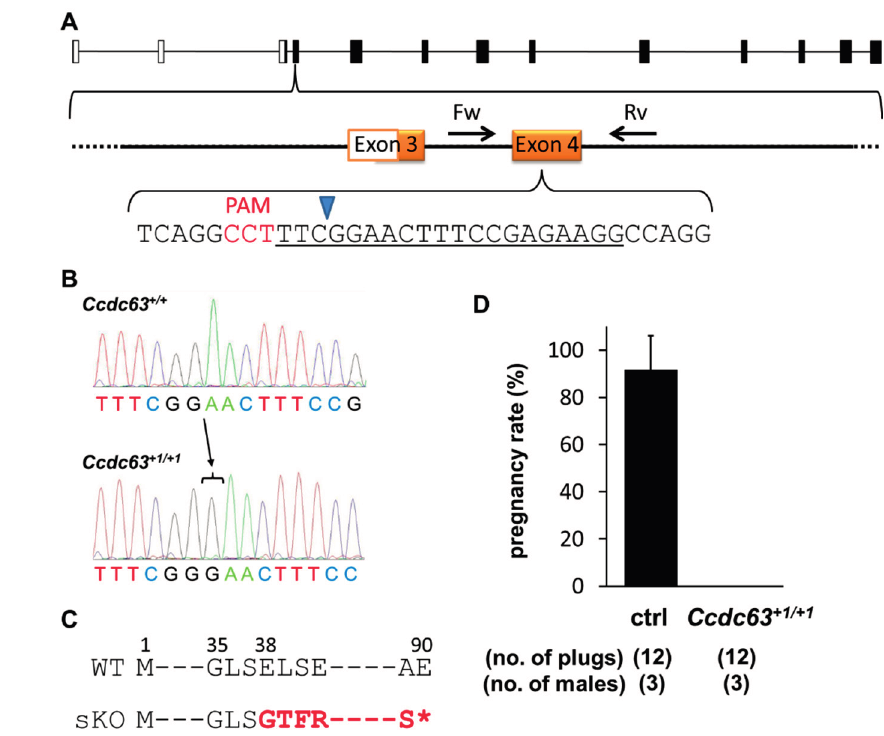
Figure 4. CRISPR/Cas9 strategy and results for Ccdc63 +1/+1 male mice. ( A ) Ccdc63 exon 4 was targeted; coding exons shown as solid black bars, non-coding exons shown as open bars. Forward (Fw) and reverse (Rv) primers for validation and genotyping shown; black arrows labelled Fw and Rv. sgRNA sequence underlined in black. PAM sequence is shown in red. Blue arrowhead indicates site of Cas9 digestion; ( B ) Sequencing of Ccdc63 +1/+1 mice; black arrow and bar indicates the nucleotide inserted; ( C ) Frameshift mutation of Ccdc63 +1/+1 , mutation shown in red, * indicates a premature stop codon. Amino acid number shown above sequence; ( D ) Natural mating analysis of Ccdc63 +1/+1 male mice with WT females. Pregnancy rate (pregnancy/vaginal plug) presented as a